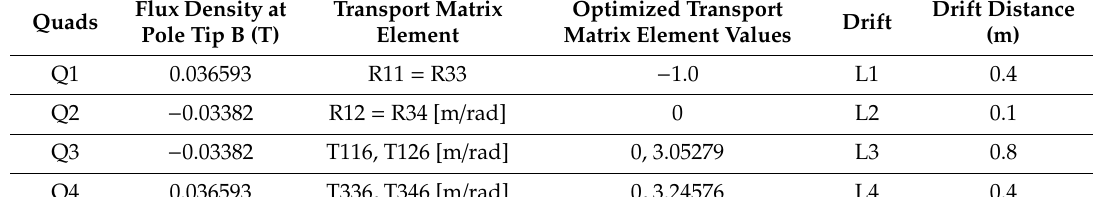
Table 1. The optimized parameters for imaging lens structure.